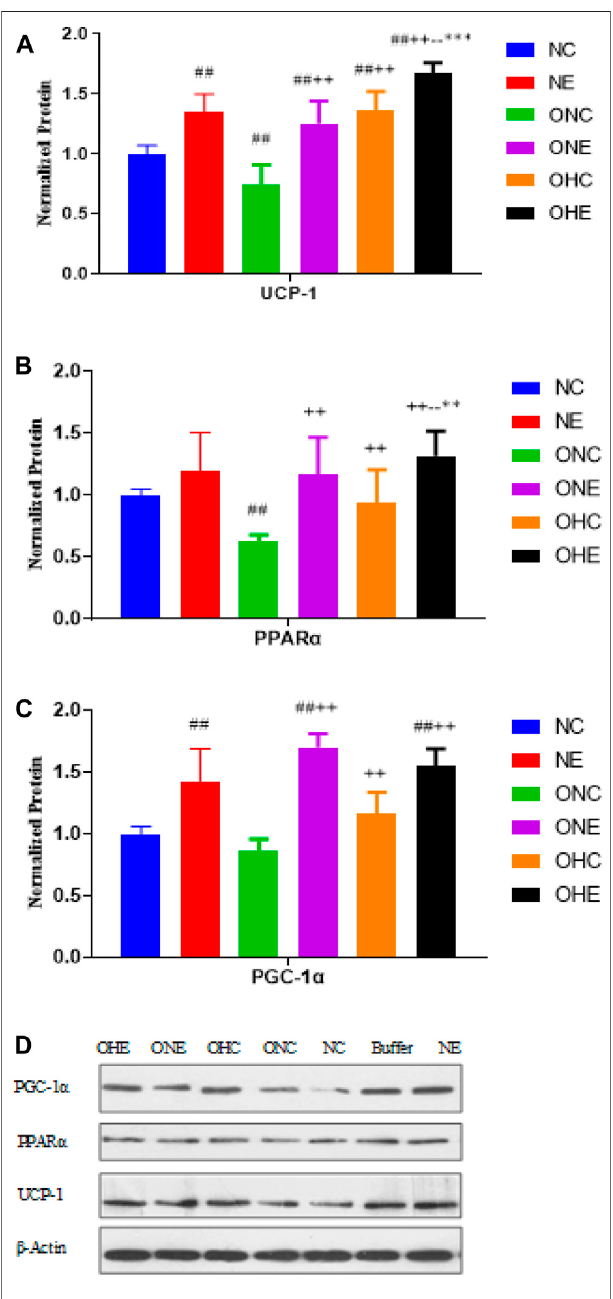
FIGURE 3 | Protein expression levels of UCP-1 (A) , PPAR α (B) and PGC-1 α (C) in inguinal adipose of rats after normoxic and hypoxic exercise. Protein expression levels of PPAR α and UCP-1 in inguinal adipose of rats in NC, NE, ONC, ONE, OHC, and OHE groups were expressed as relative levels based on the expression level of β -Actin (D) . n = 8, # p < 0.05 vs. NC group; ## p < 0.01 vs. NC group; + p < 0.05 vs. ONC group; ++ p < 0.01 vs. ONCgroup;- p < 0.05vs.ONEgroup;-- p < 0.01vs.ONEgroup;* p < 0.05vs. OHC group; ** p < 0.01 vs. OHC group; following tables same.